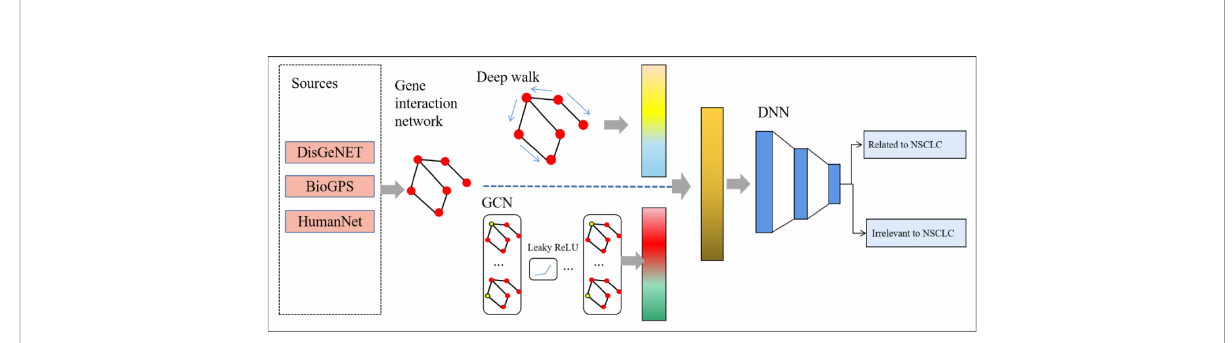
FIGURE 1 The structure of deepRW. GCN, graph convolutional network; DNN, deep neural